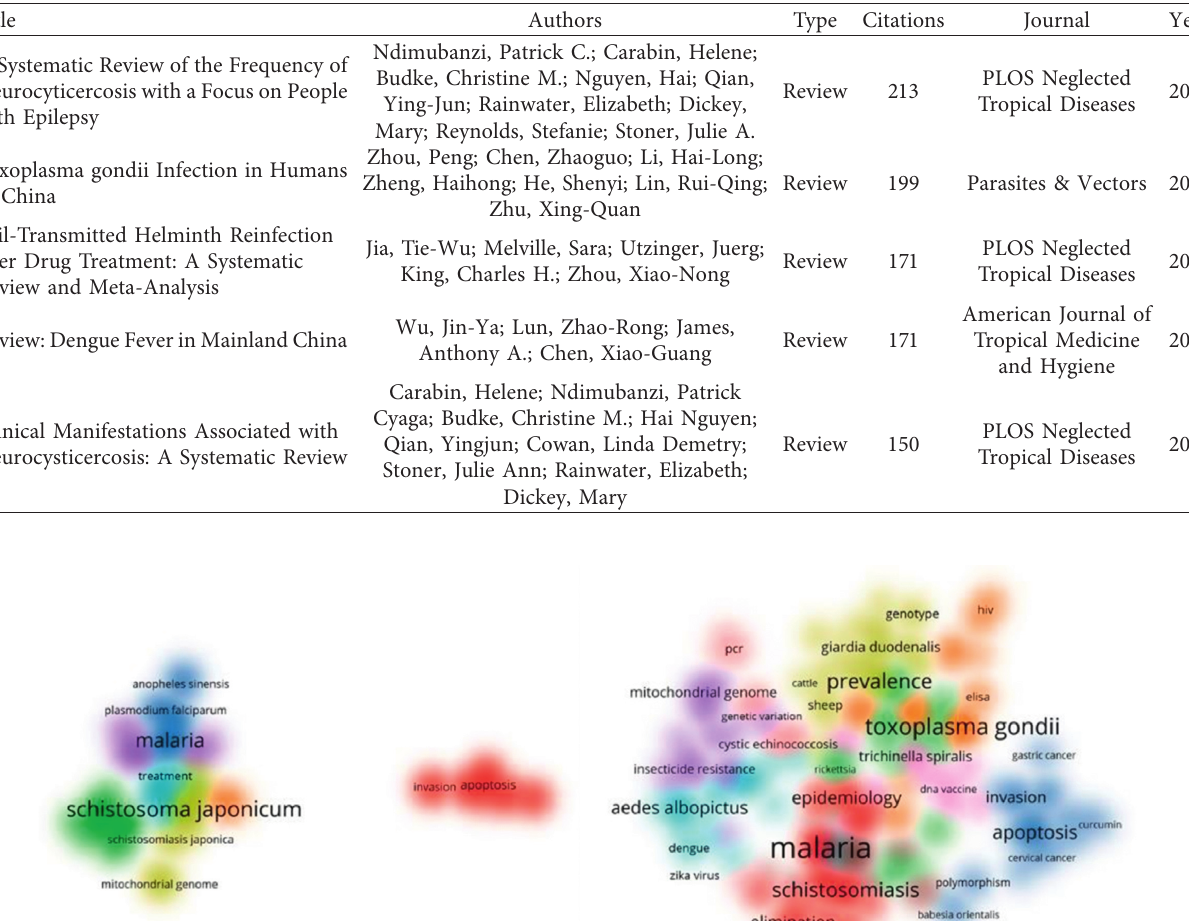
Table 4: The most cited reviews in the field of tropical medicine, 2010–2019.